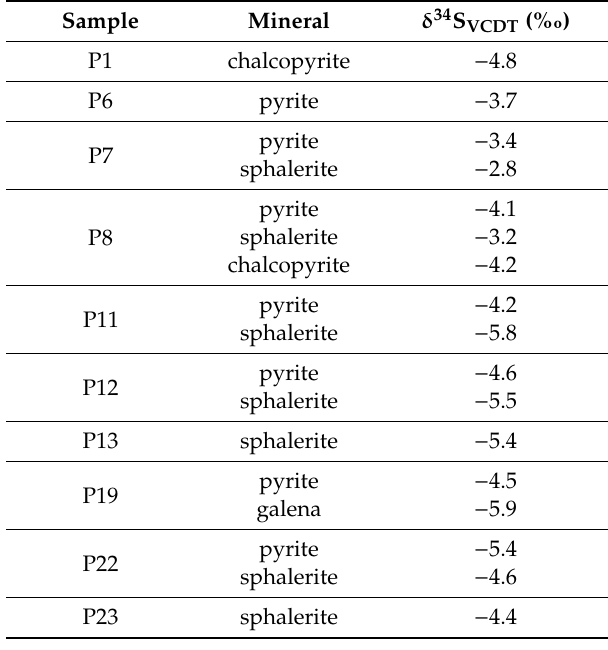
Table 2. Sulphur isotopic composition of sulphides in the Poop ó deposit (Bolivia), normalised to the Vienna-CDT (VCDT)